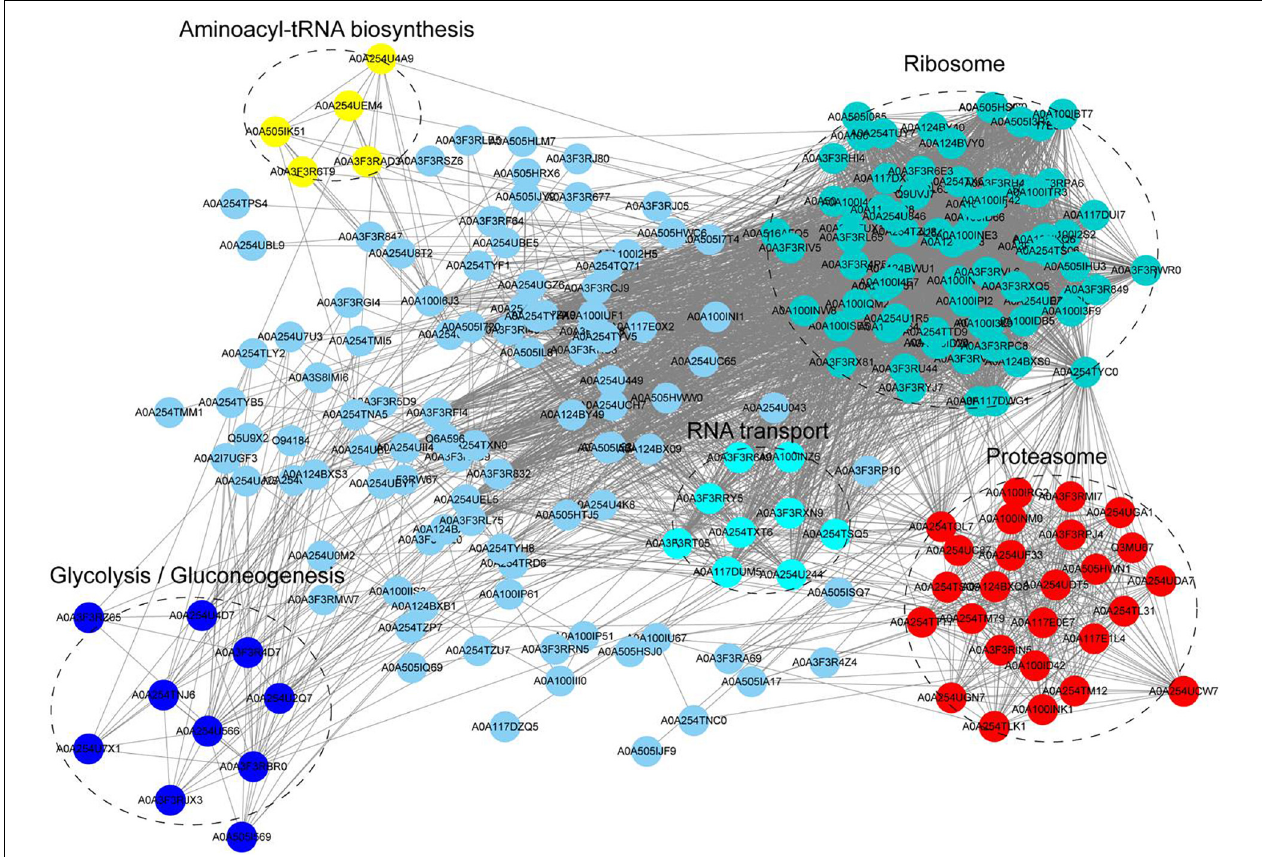
FIGURE 5 | Protein-protein interaction (PPI) network of Khib proteins in A. niger . Five clusters of highly interconnected Khib proteins were associated with aminoacyl-tRNA biosynthesis, ribosome, glycolysis/gluconeogenesis, RNA transport and proteasome. These clusters were indicated by different colors and circled black